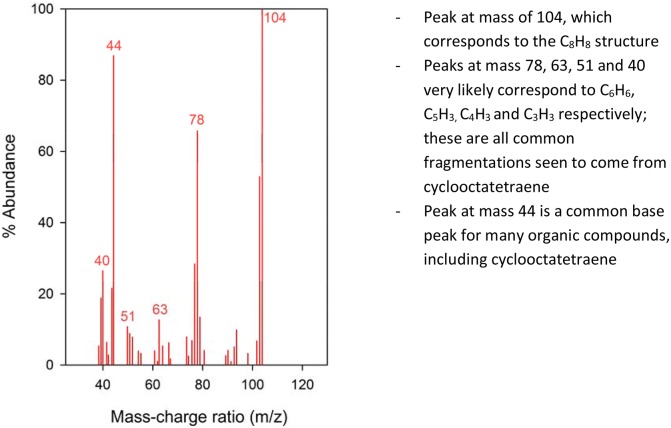
Section of mass spectrum corresponding to unique GC peaks.Peak at mass of 104, which corresponds to the C8H8 structure. Peaks at mass 78, 63, 51 and 40 very likely correspond to C6H6, C5H3, C4H3, and C3H3 respectively; these are all common fragmentations seen to come from cyclooctatetraene. Peak at mass 44 is a common base peak for many organic compounds, including cyclooctatetraene.